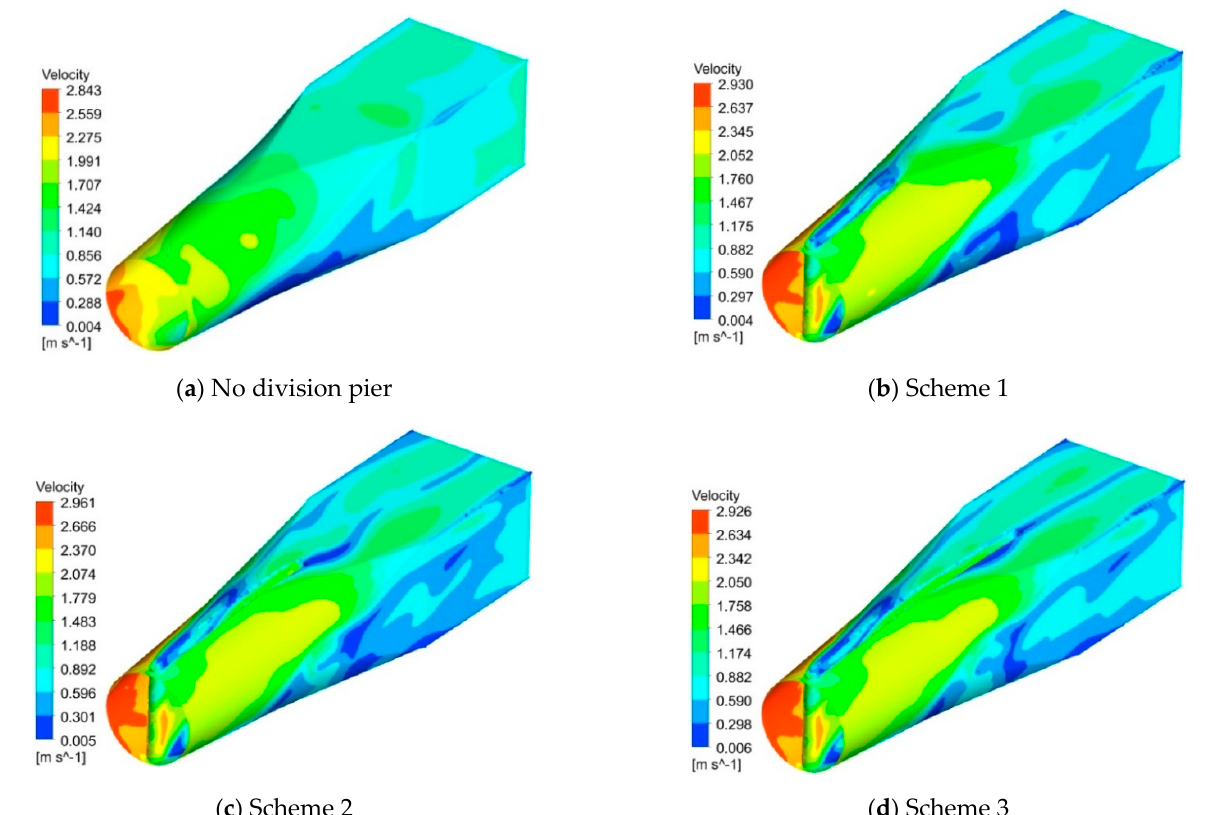
Figure 14. Velocity nephogram of the near–wall area of the straight outlet conduit.